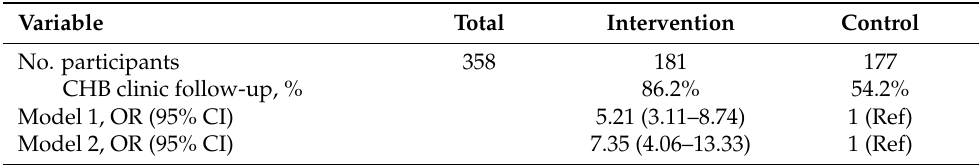
Table 2. Odds Ratio of CHB Clinical Follow-up at 12 Months of the Intervention Group Against the Control Group, Results from Descriptive Analysis and Generalized Linear Mixed-Effect Models. Variable